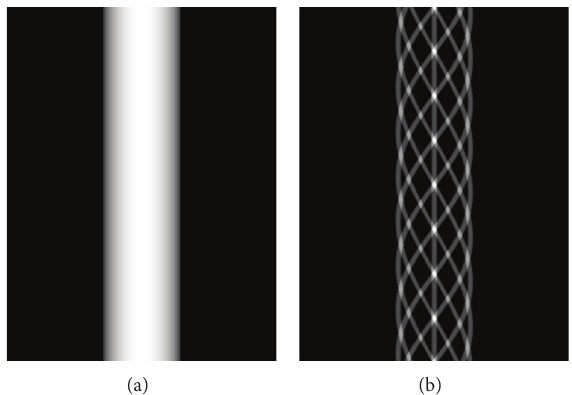
Figure 3: CBCT sinograms for the central slice of the (a) disk phantom and the (b) sphere